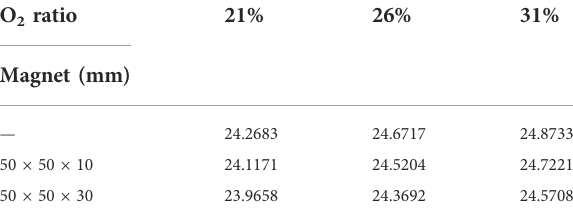
TABLE 4 Peak diffraction values of θ 002 of the soot.